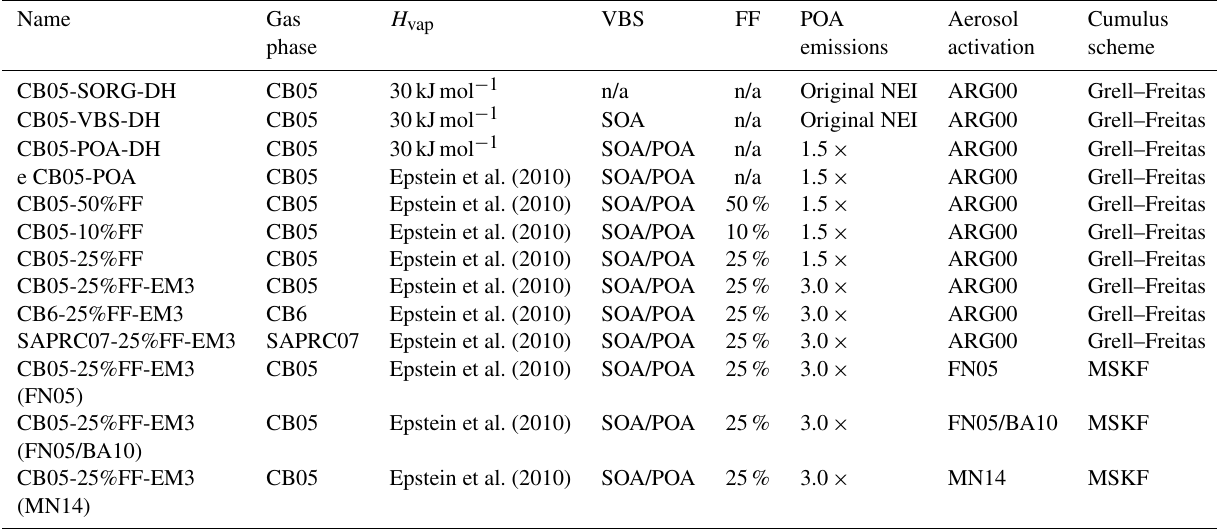
Table 4. Configurations for OA and aerosol activation sensitivity simulations. All simulations except for CB05-SORG-DH contain the VBS treatments for